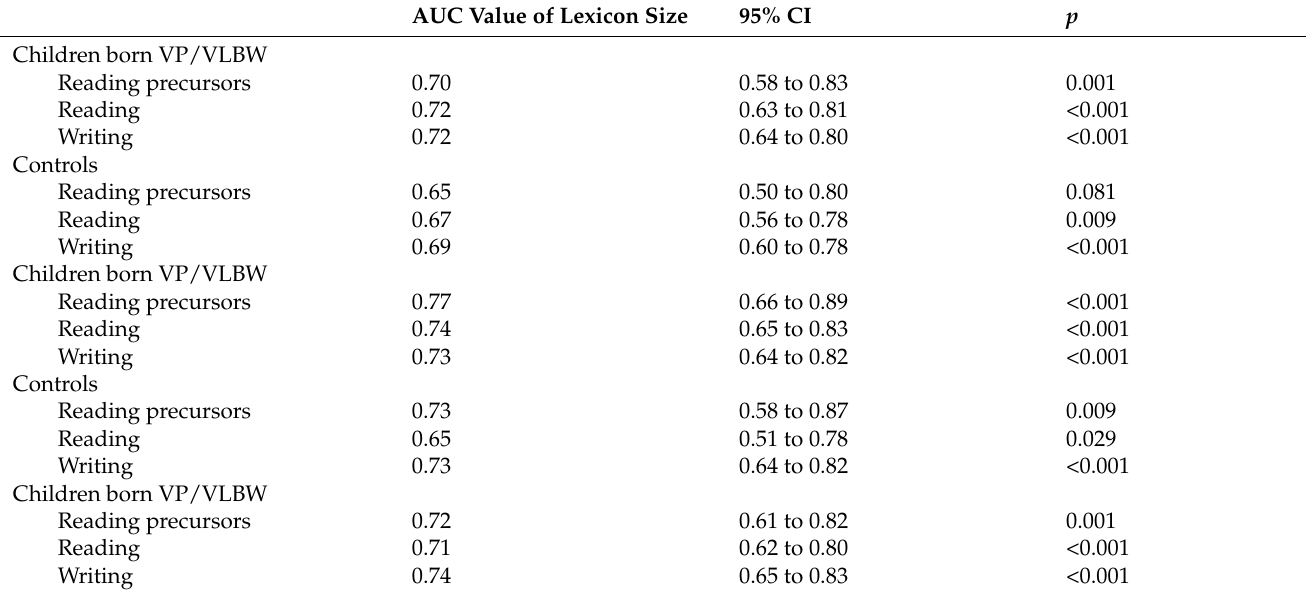
Table 8. Area under the receiver operating characteristic (ROC) curve (AUC) values for weak reading precursors (sum score < 25, 10th percentile), weak reading (0 words, 10th percentile), and weak writing (0 words, 10th percentile) skills at 7 years with lexicon size/M3L/ELS at 2 years as predictor